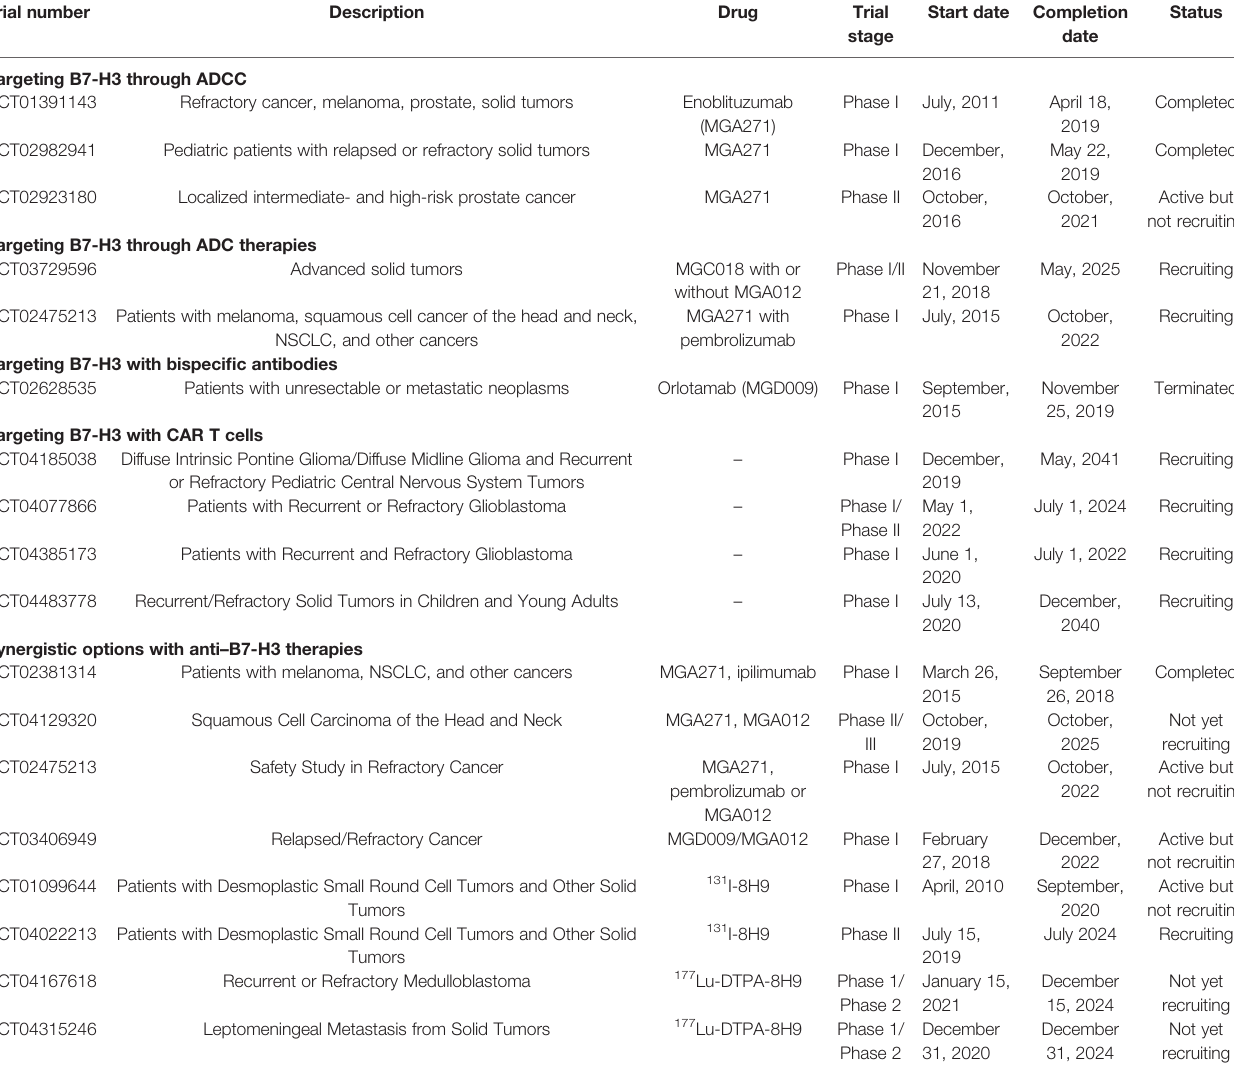
TABLE 2 | Summary of the clinical trials on anti B7-H3 antibodies for hematologic and solid tumor